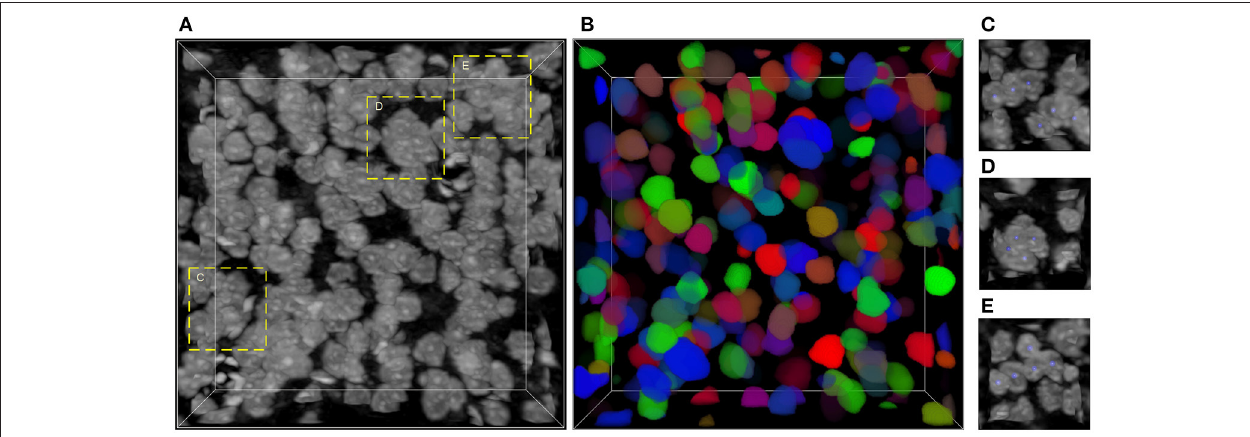
FIGURE 1 | Nissl-stained dataset. (A) Raw volumetric data. (B) Manual labels; each neuronal soma is labeled by unique random color. (C–E) Regions contain touching neuronal somata, labeled by dash bounding boxes in (A) ; the neuronal soma centers are labeled using blue balls. The intensity of raw data is adapted for visualization. The shape of this volumetric data is 286 × 286 × 86 voxels, and the voxel size is 0.35 × 0.35 × 0.35 µ m.